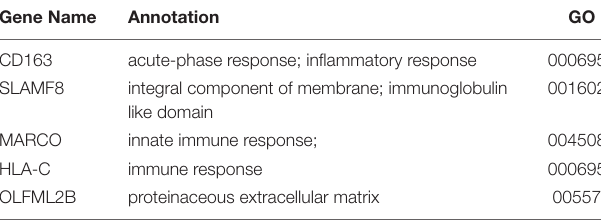
TABLE 2 | The Annotation of different expression genes.